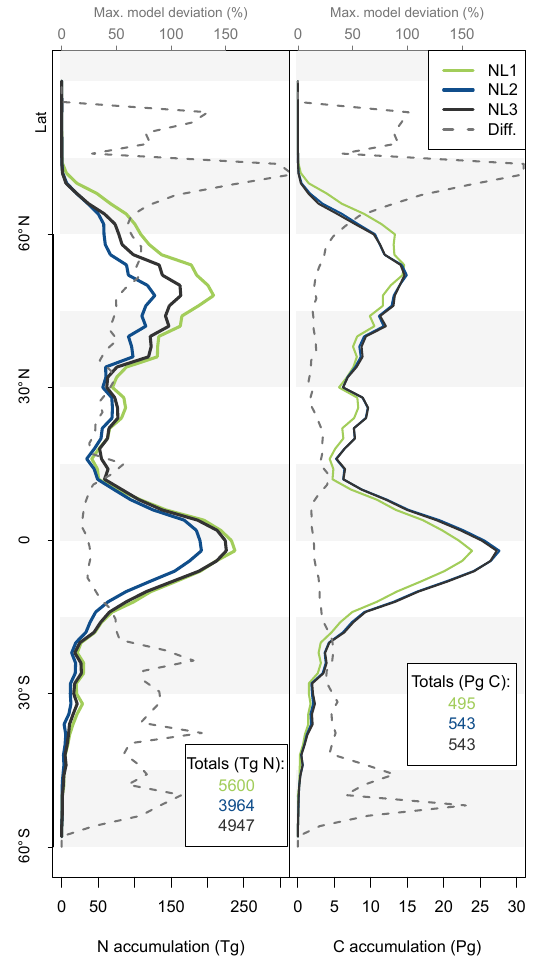
Figure 5. Nitrogen (N, left) and carbon (C, right) accumulation during global simulations of elevated atmospheric CO 2 concen- trations (eCO 2 ) using three different N loss algorithms between 1850 (285ppm CO 2 ) and 2100 (936ppm CO 2 ), depicted per 2 ◦ latitudinal band and as global totals (coloured numbers). “Diff.” shows the respective maximum deviation between the three mod- els as the percentage of the three-model mean. The global to- tal values corresponded to average yearly accumulations of 22.4, 15.9, and 19.8TgNyr − 1 (NL1, NL2, and NL3) and 2.0, 2.2, and 2.2PgCyr − 1